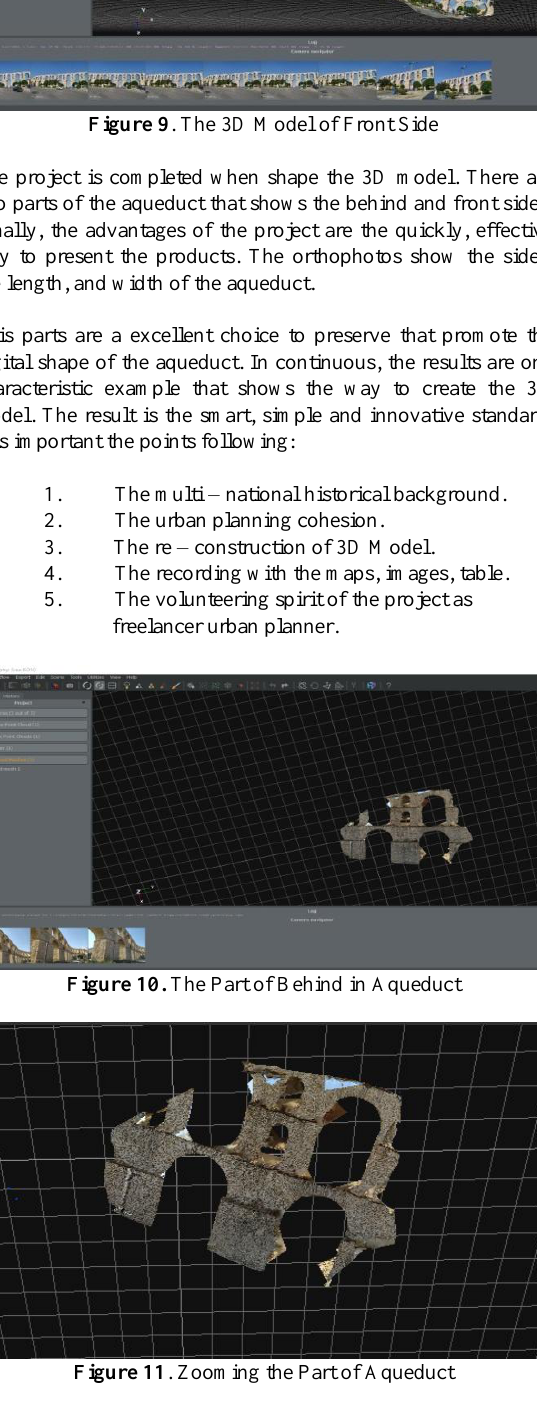
Figure 8 . The Point Cloud